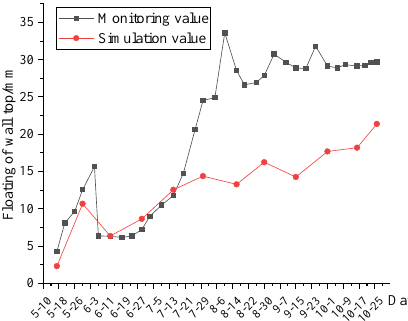
Figure 12. Floating time curve on the top of the wall.